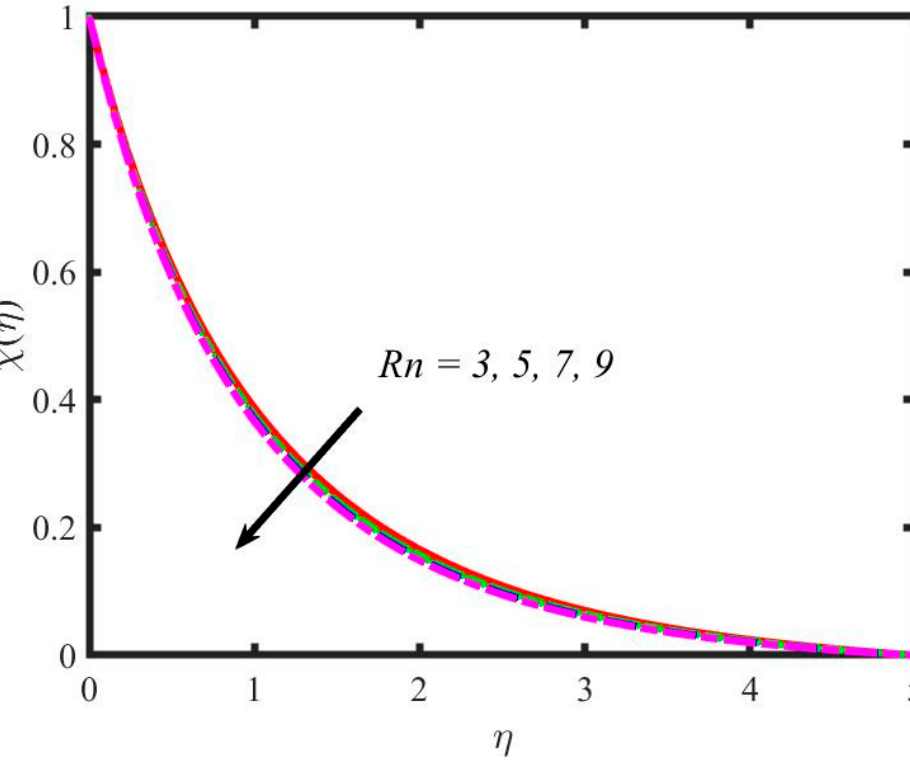
Figure 22. Variations in microorganism profile for radiation parameter.